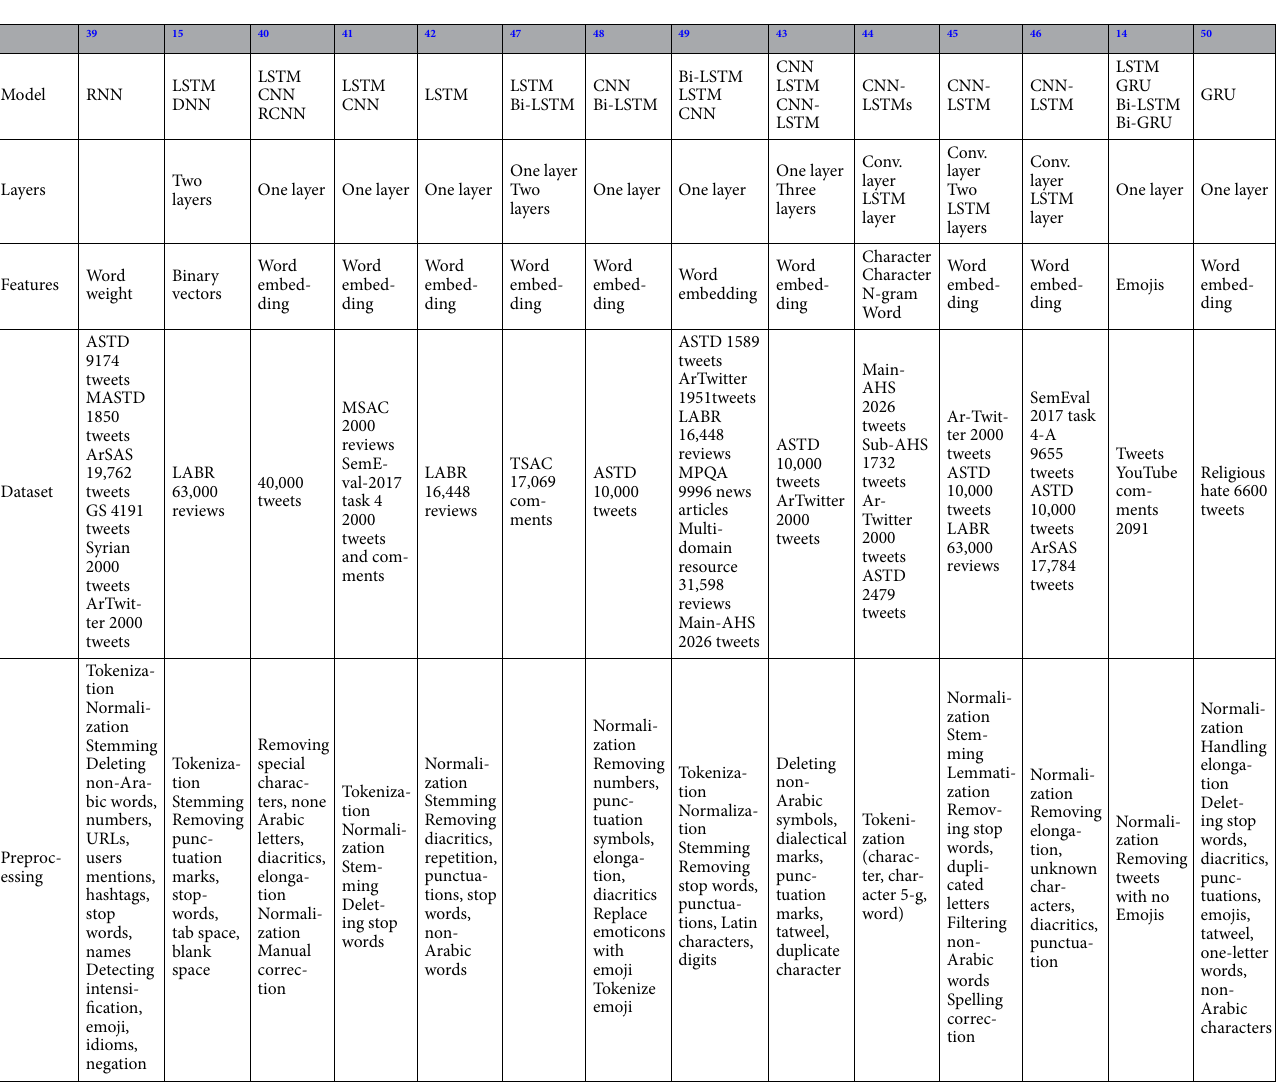
Table 1. Arabic sentiment analysis using RNNs and gated